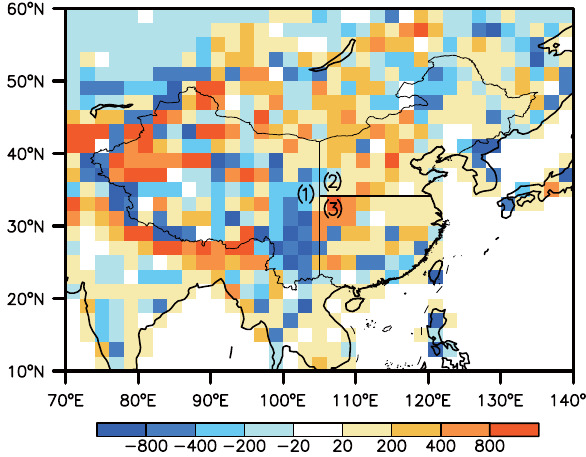
Fig. 1. Topography differences (units: m) between mid-Pliocene and pre-industrial experiments provided by PRISM3. Regions (1), (2) and (3) represent western China, north monsoon China and south monsoon China, respectively. Regions (2) and (3) together represent monsoon